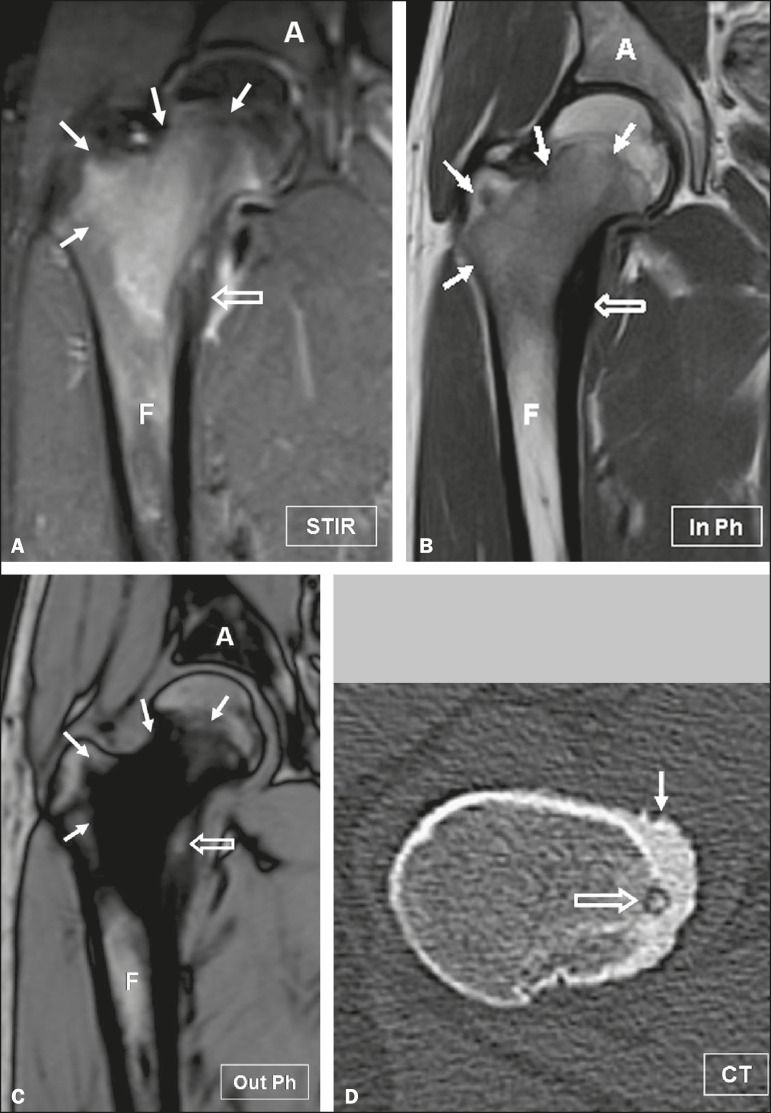
Osteoid osteoma in an 18-year-old male patient presenting with pain in
the right hip. A: Coronal short inversion-time inversion
recovery MRI sequence showing the high signal intensity of the lesion
(arrows) and cortical thickening (open arrow). Coronal in-phase and
out-of-phase spoiled gradient-echo MRI sequences (B and
C, respectively) showing high signal intensity of a
portion of the lesion (open arrow) on out-of-phase images, predicting
the tumor nidus. Note the low signal intensity of the surrounding bone
marrow (arrows), corresponding to inflammatory tissue. D:
Reformatted axial computed tomographic image showing cortical thickening
(arrow) and the nidus (open arrow), confirming the diagnosis of osteoid
osteoma. A, acetabulum; F, femur.